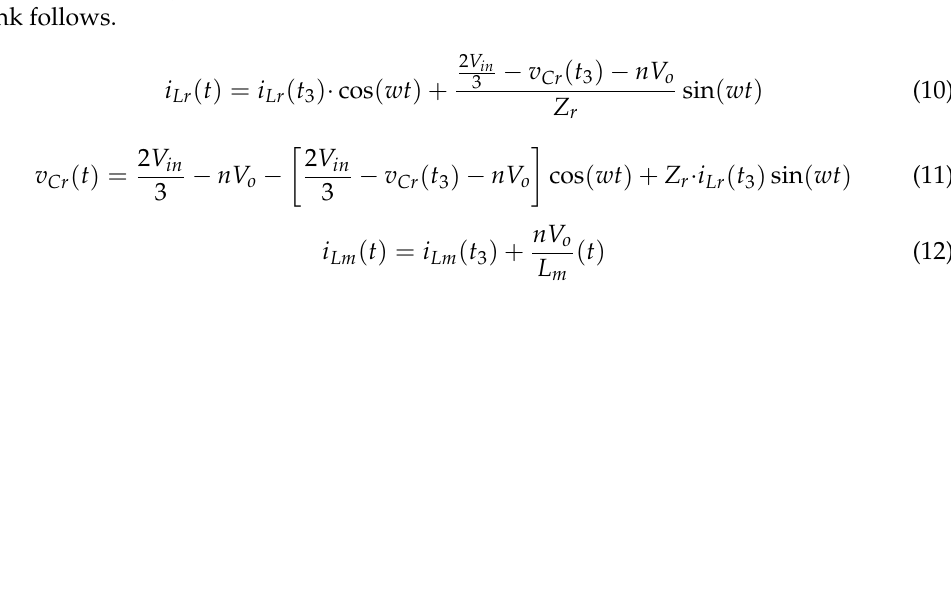
(b) Figure 7. ( a ) Circuit station at Stage 4 ( b ) Equivalent circuit at Stage 4.